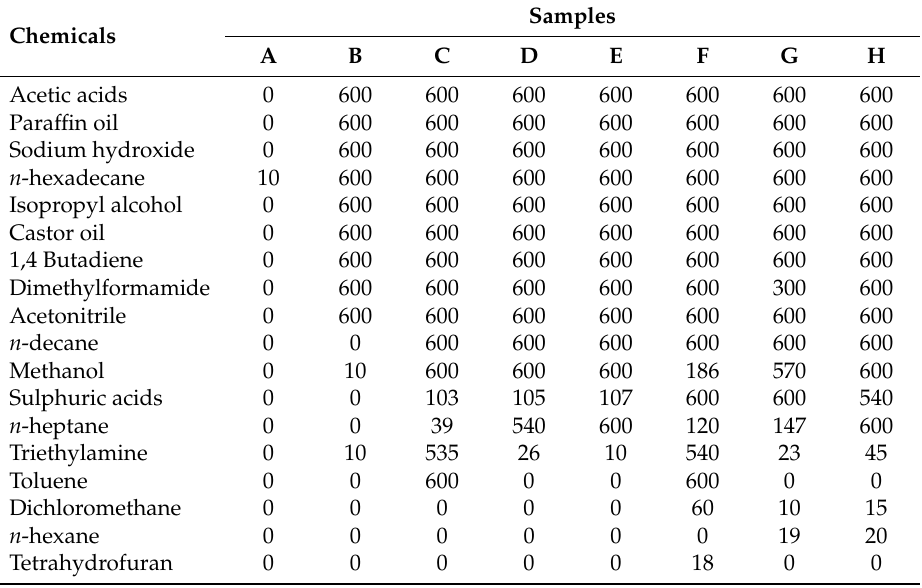
Table 1. Chemical resistance (s) of uncoated and coated cotton fabrics.